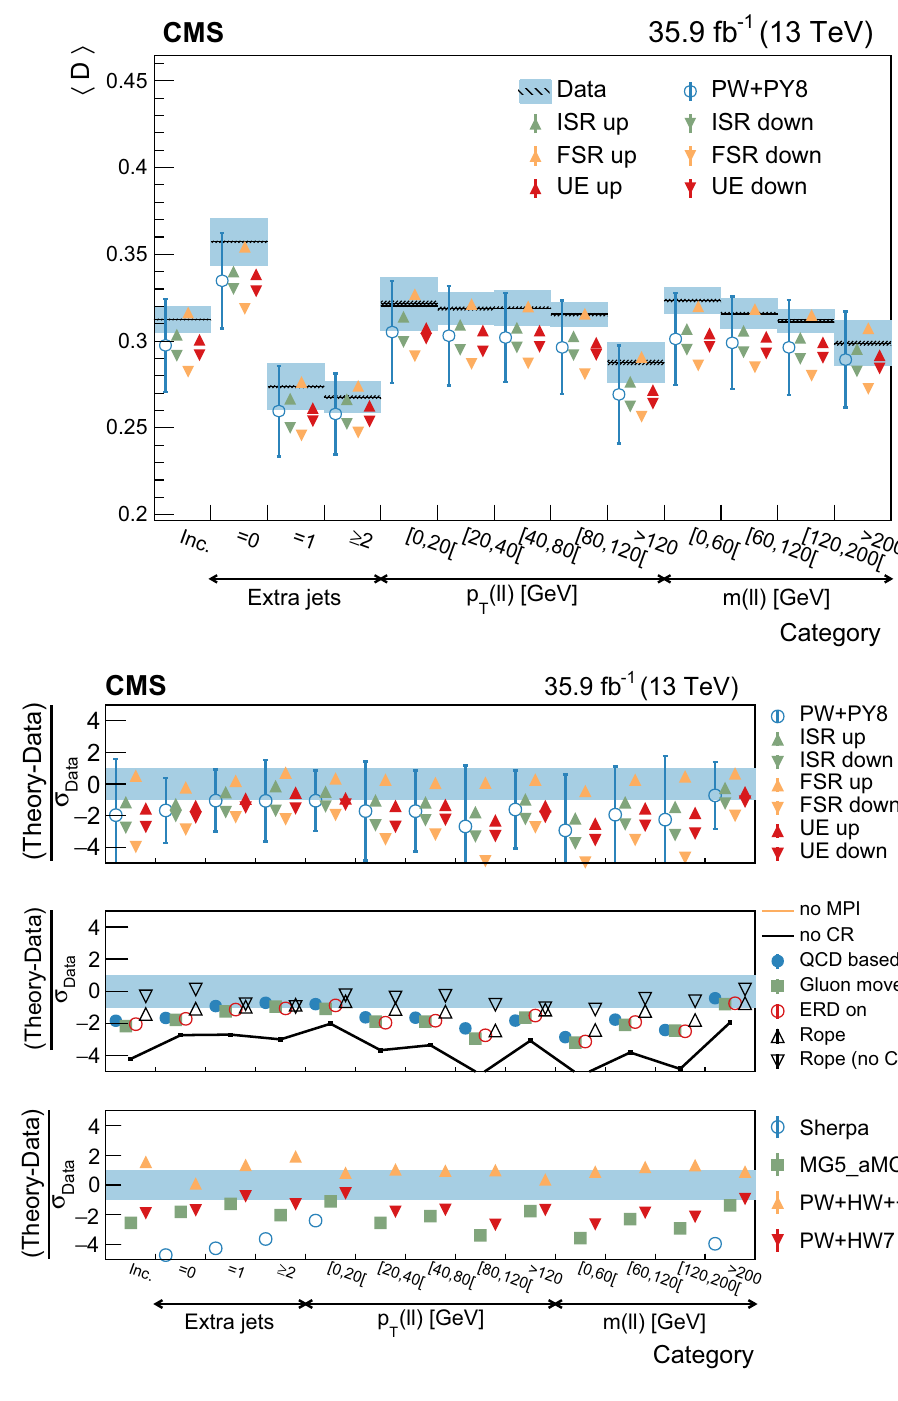
Fig. 23 Average D in different categories. The conventions of Fig. 14 are